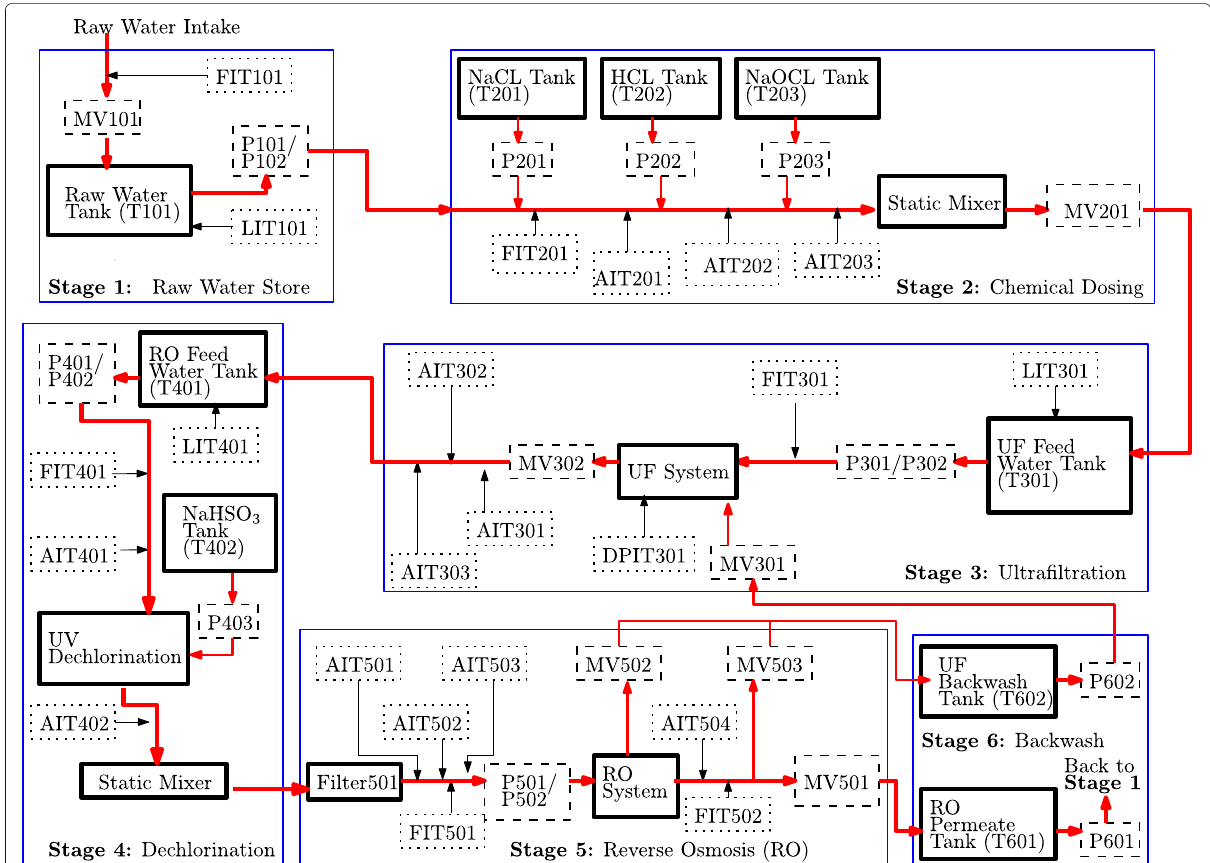
Fig. 1 Overview of the six stages of SWaT. Thick red arrows indicate the flow of water; dotted and dashed rectangles respectively indicate sensors and actuators; thick black rectangles indicate tanks and sub-systems; and blue rectangles indicate the